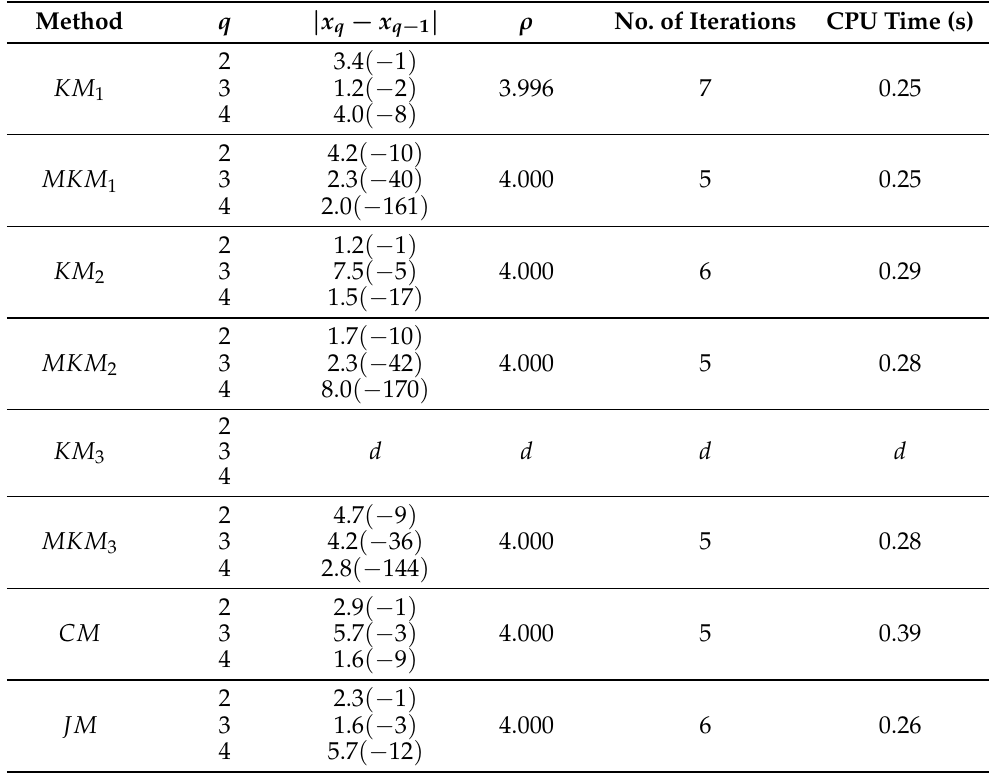
Table 4. Example 4(a) at initial point x 0 = 2.